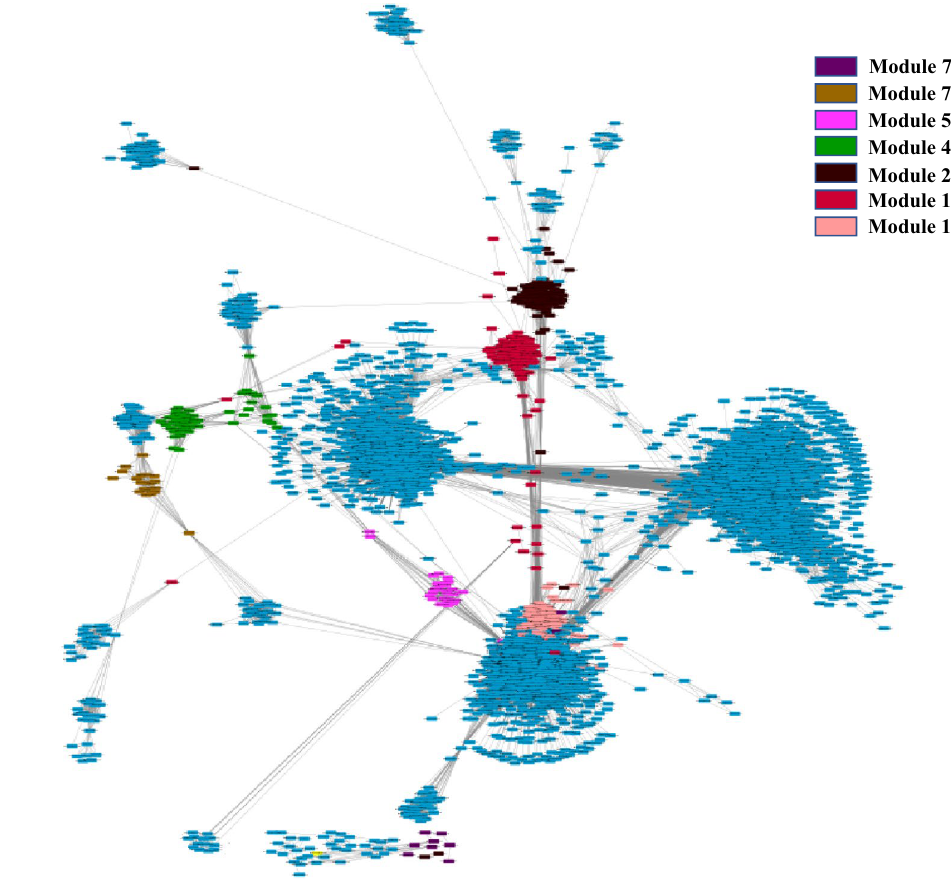
Figure 5. Modules of interest in gene co-expression network of SARS-CoV-2 infected humans are highlighted in different colors as indicated in the legend